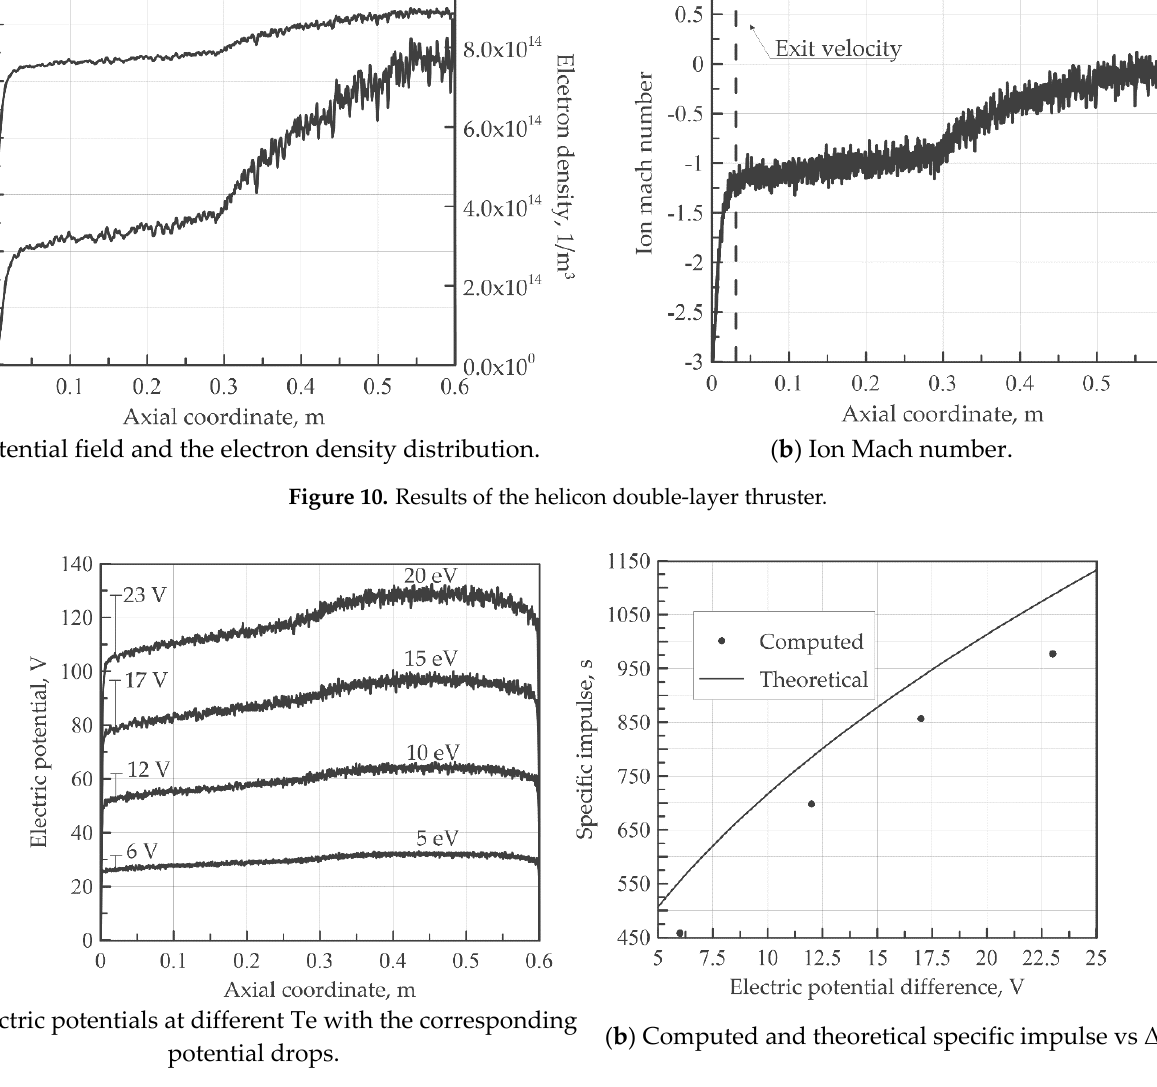
Figure 11. Effect of the electron temperature on the electric potential, potential drop, and the computed and the specific impulse at constant ionization rate 1 × 10 18 .